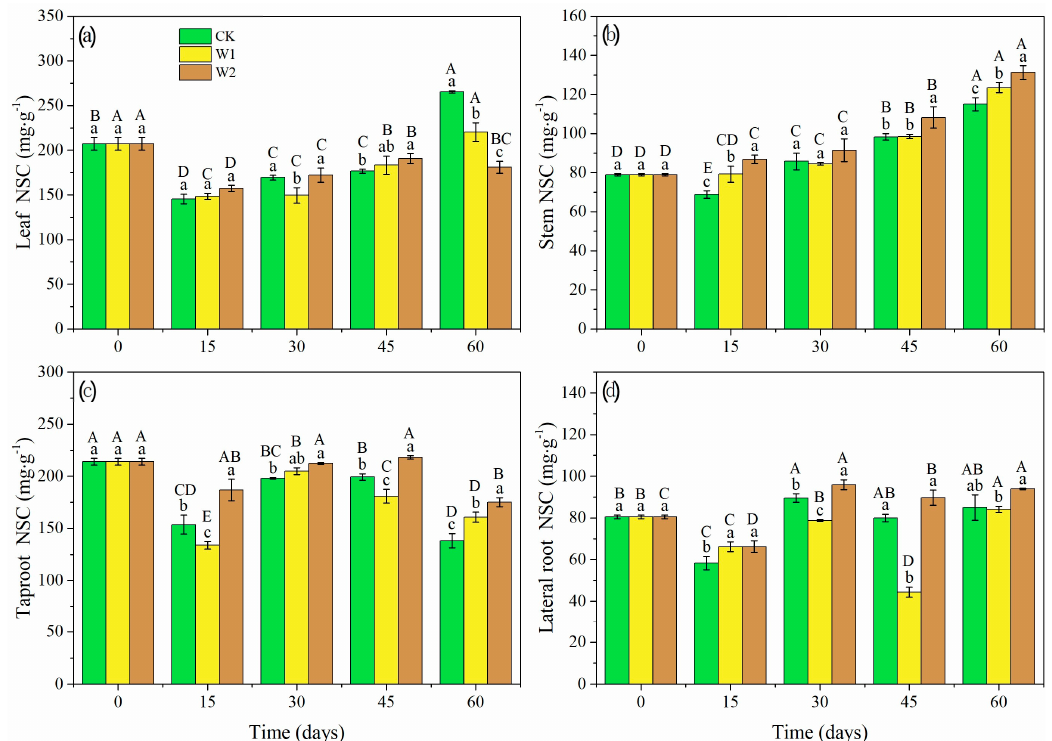
Figure 6. Leaf NSC content ( a ), stem NSC content ( b ), taproot NSC content ( c ) and lateral root NSC content ( d ) of Mongolian oak seedlings under different drought intensities and durations. Uppercase letters represent the significant differences in the same treatment at different times ( p < 0.05), and lowercase letters represent the significant differences between different treatments at the same time ( p <